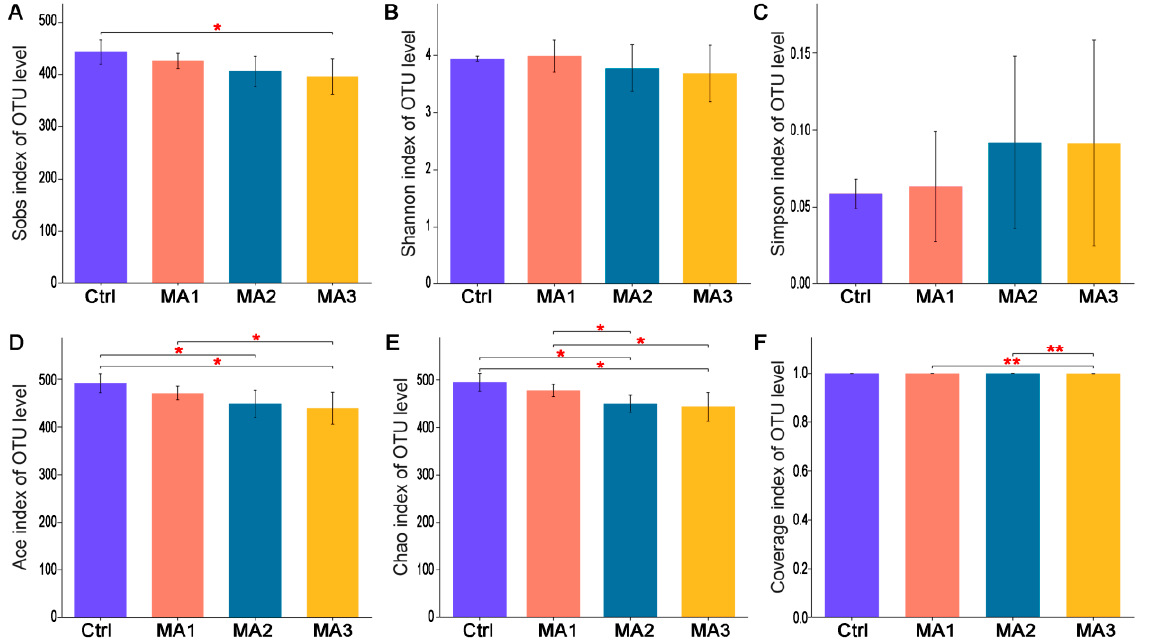
Figure 1. The α − diversity of cecal microbiota of broilers. It was indicated by Sobs ( A ), Shannon ( B ), Simpson ( C ), Ace ( D ), Chao ( E ), Coverage ( F ) indexes of operational taxonomic unit (OTU) level. Ctrl: the control group fed the basal diets; MA 1, 2, 3: the experimental groups fed the basal diets supplemented with 4, 8, and 12 g/kg of bio-fermented malic acid, respectively. * means significant differences between groups ( p < 0.05). ** means significant differences between groups ( p < 0.01).